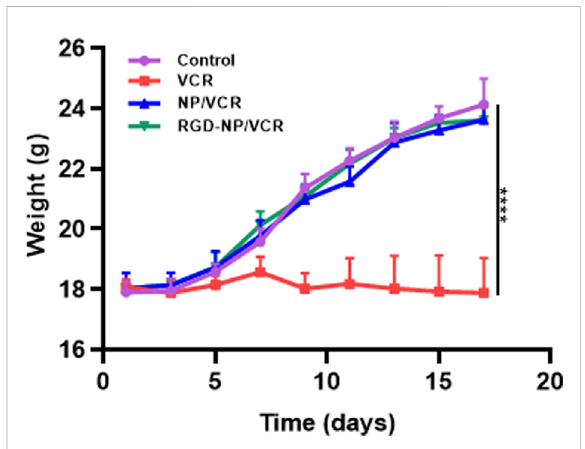
FIGURE 7 The body weight analysis of mice in each group. The data in